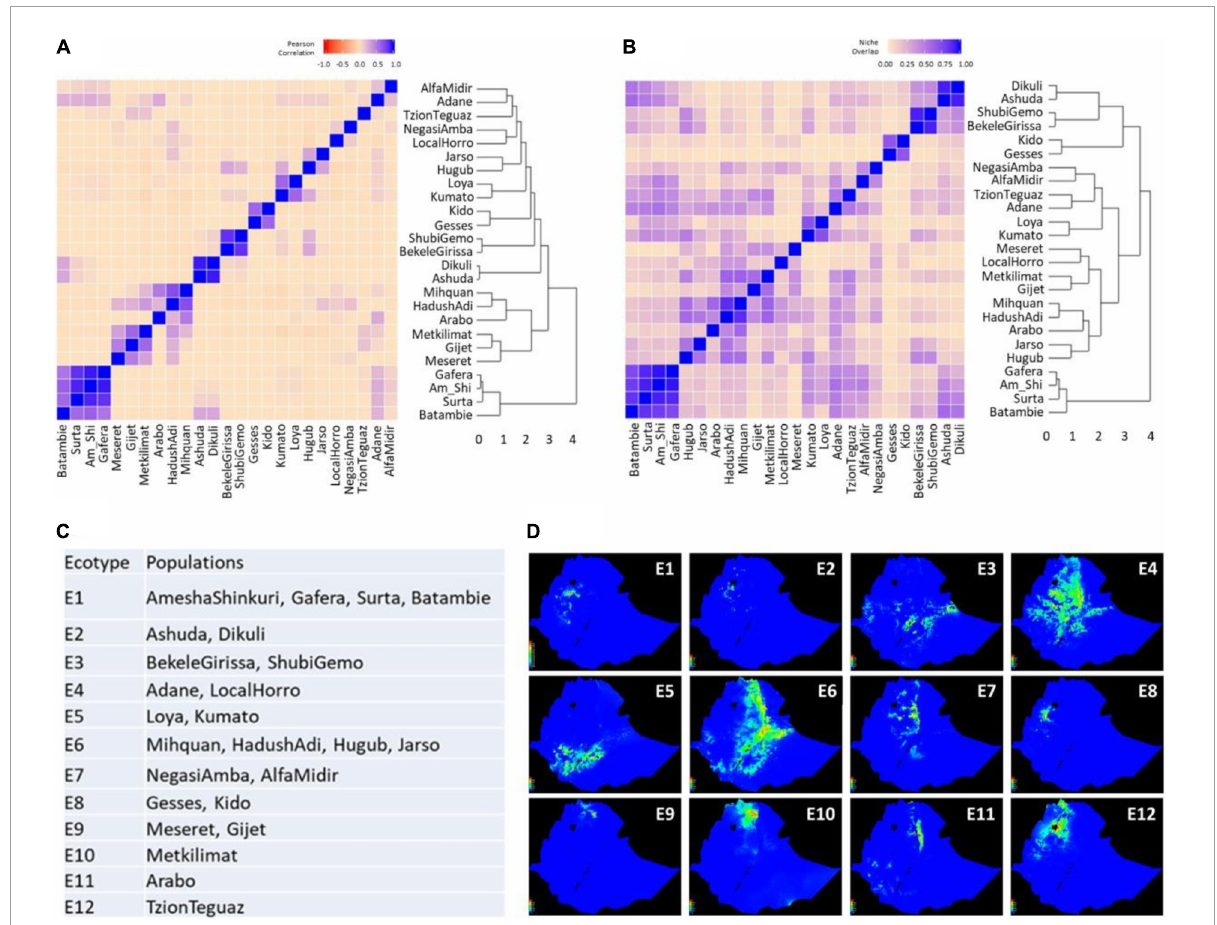
FIGURE5 Delineation of ecotypes based on niche similarity among 25 Ethiopian chicken populations examined. (A) Dendrogram and heatmap of pairwise Pearson correlation ( I ) among 25 populations; (B) dendrogram and heatmap of pairwise niche overlap statistic ( r ) among 25 populations; (C) 12 delineated ecotypes and their population composition; and (D) suitability maps of 12 delineated